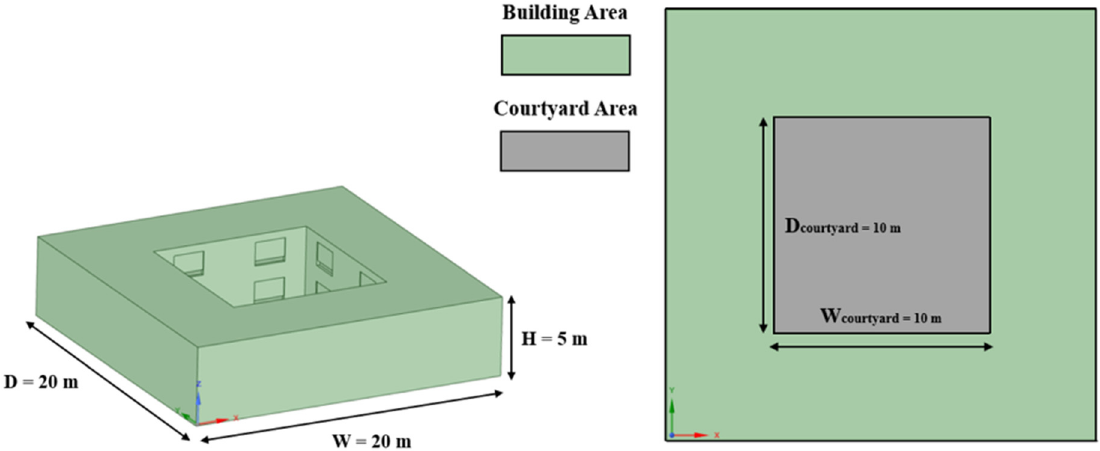
Figure 2. Courtyard model and dimensions.